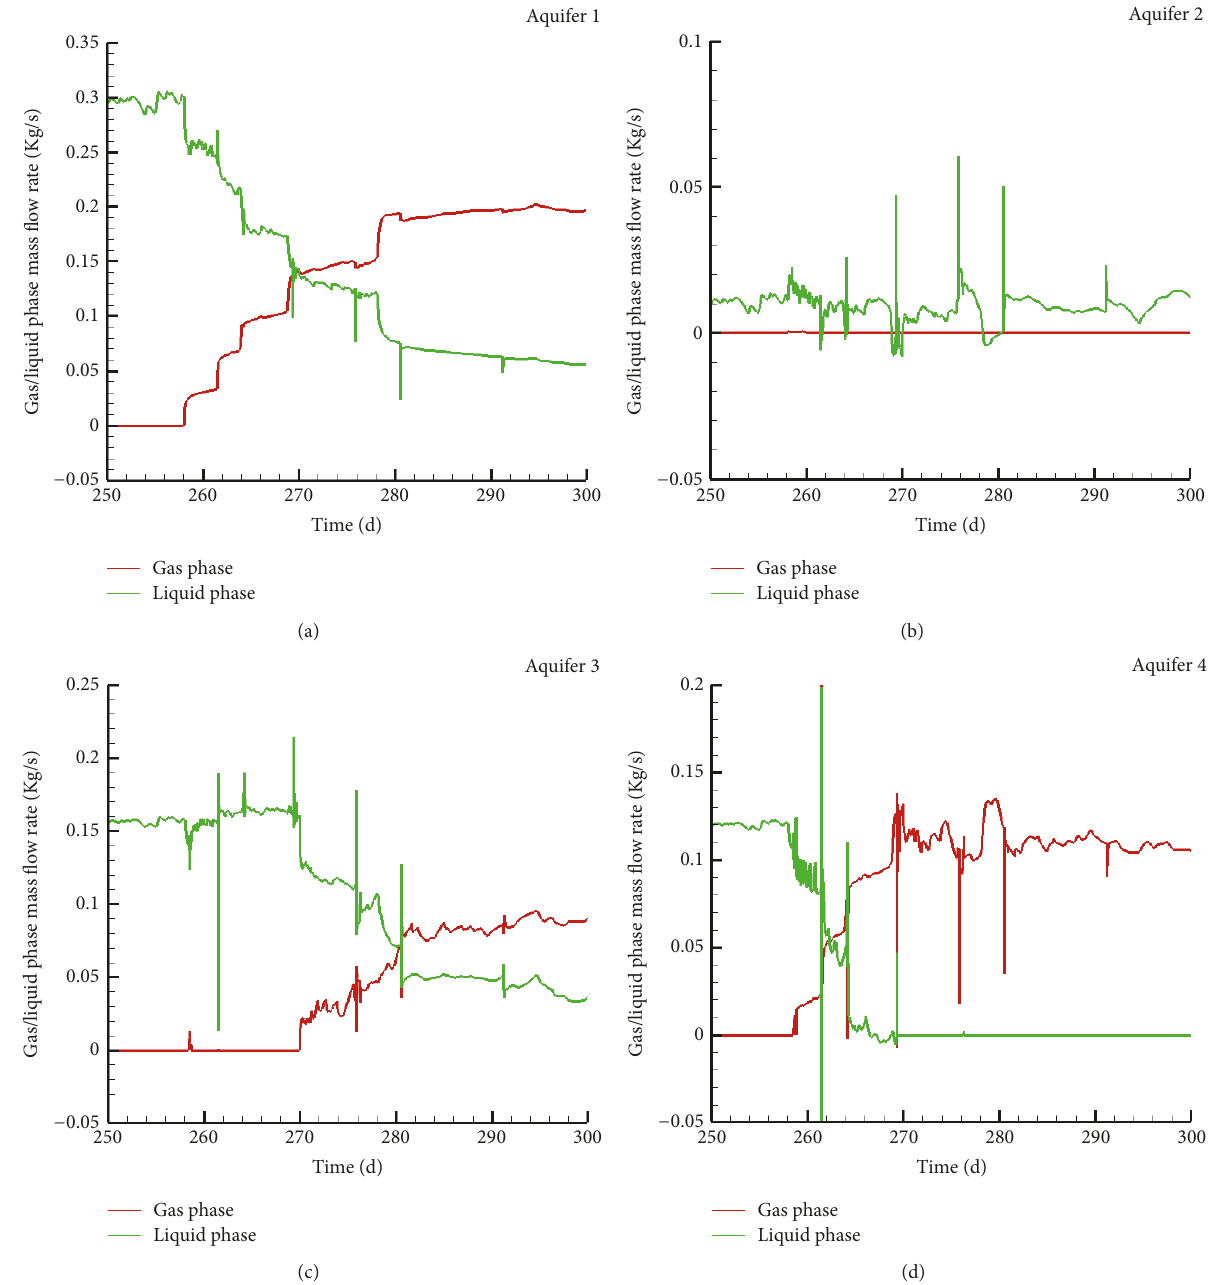
Figure 7: Phases mass flow rate at the interfaces of fracture and various aquifers in Case 1 before and after gaseous CO 2 breakthrough.